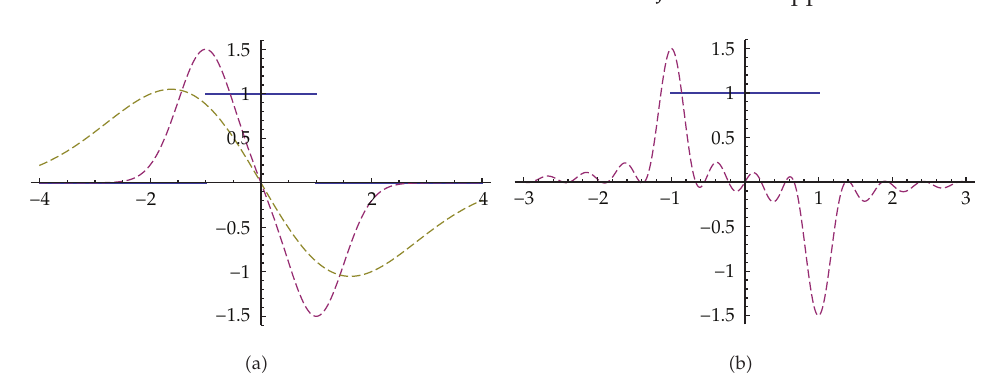
Figure 9: Noise-free signal s (cid:2) (cid:3) t (cid:4) (cid:3) –– (cid:4) generated by di ff erent scanning beams: (cid:3) a (cid:4) Gaussian beam with ω x (cid:5) 1 and ω x (cid:5) 3, (cid:3) b (cid:4) beam with intensity distribution given by (cid:3) 4.2 (cid:4)